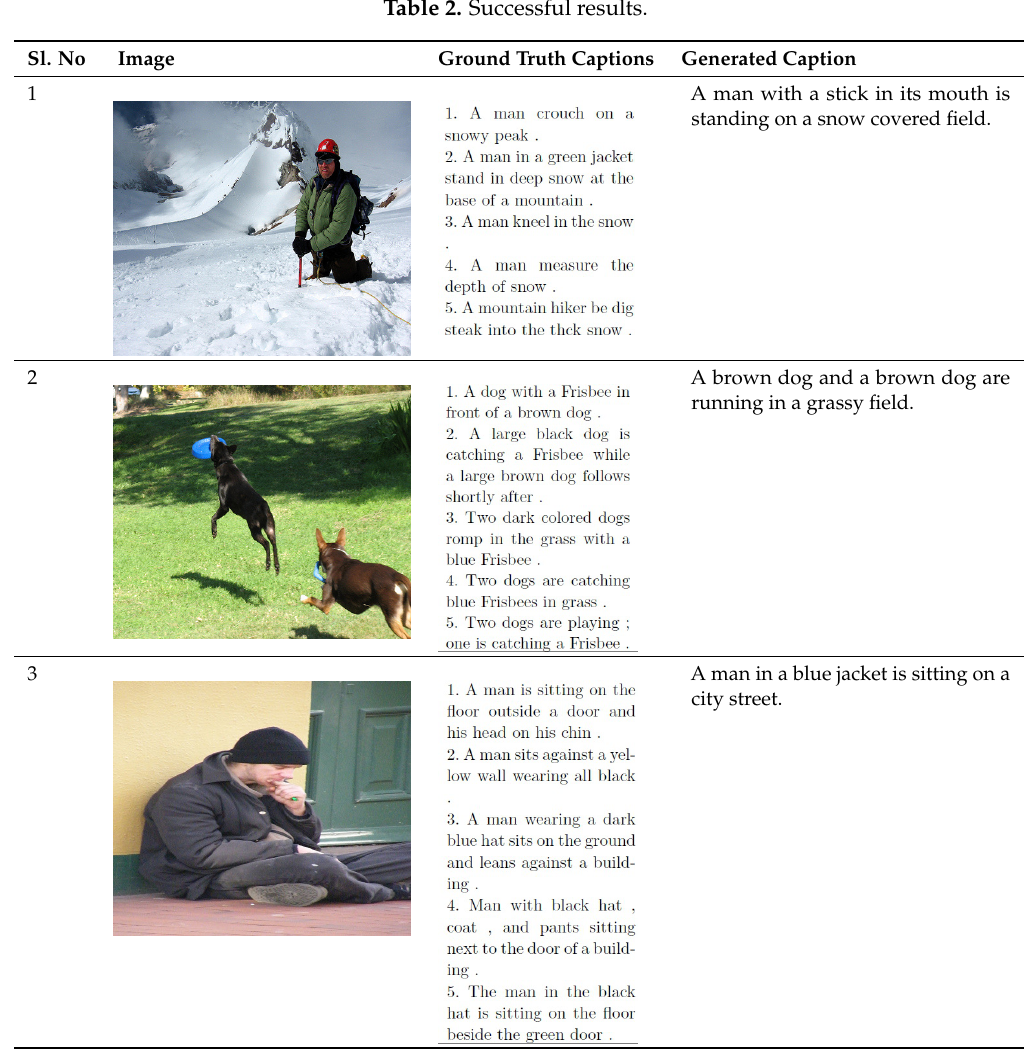
Table 2. Successful results.